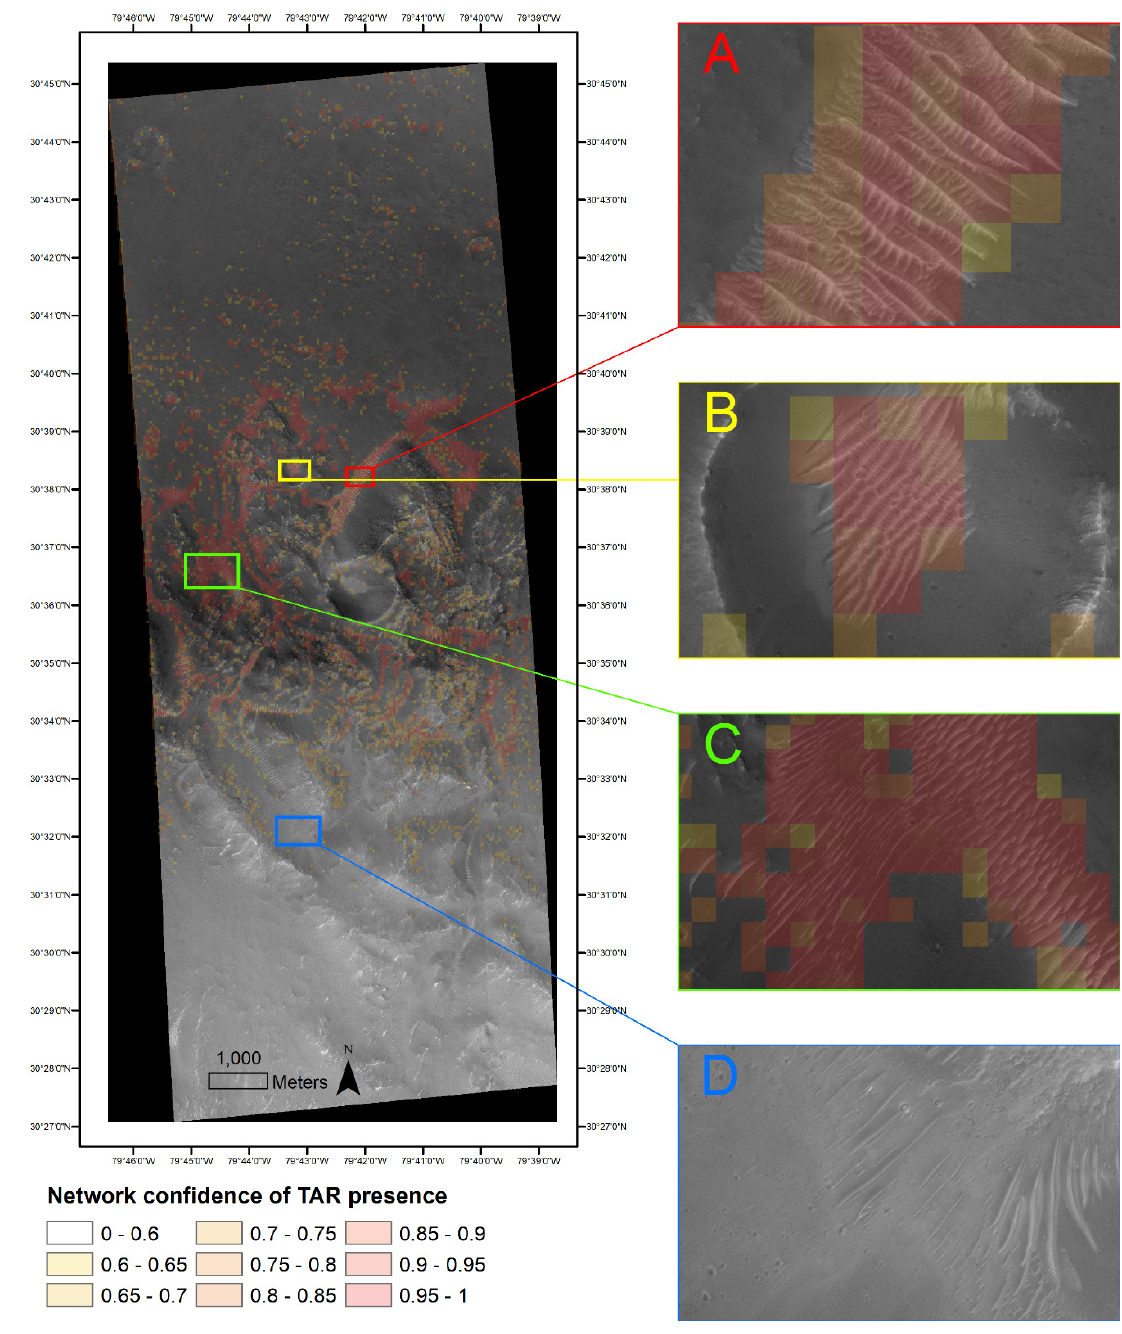
Figure 4. The test image with network overlay. Warmer colors indicate greater confidence in the network’s label. Tiles below the confidence threshold of 60% are not labeled. The four insets ( A – D ) show detailed views of network detections and TAR morphologies.